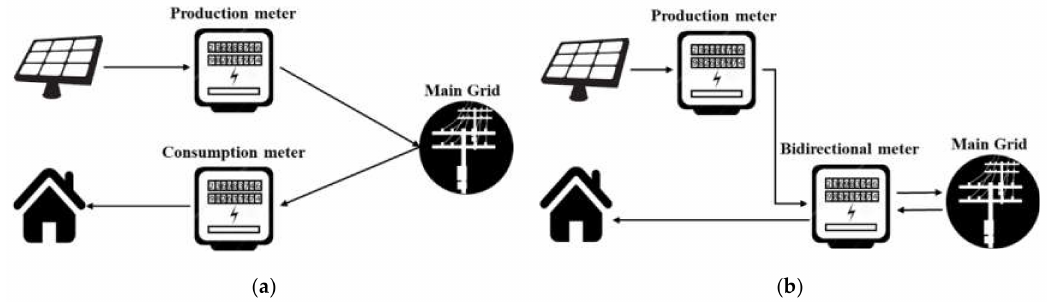
Figure 3. UPP schemes, ( a ) Two unidirectional meters, and ( b ) One unidirectional and one bidirectional